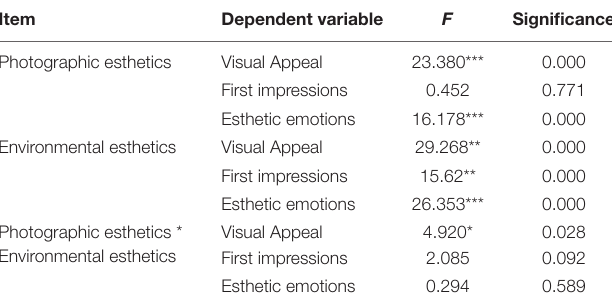
TABLE 3 | ANOVA results: self-report